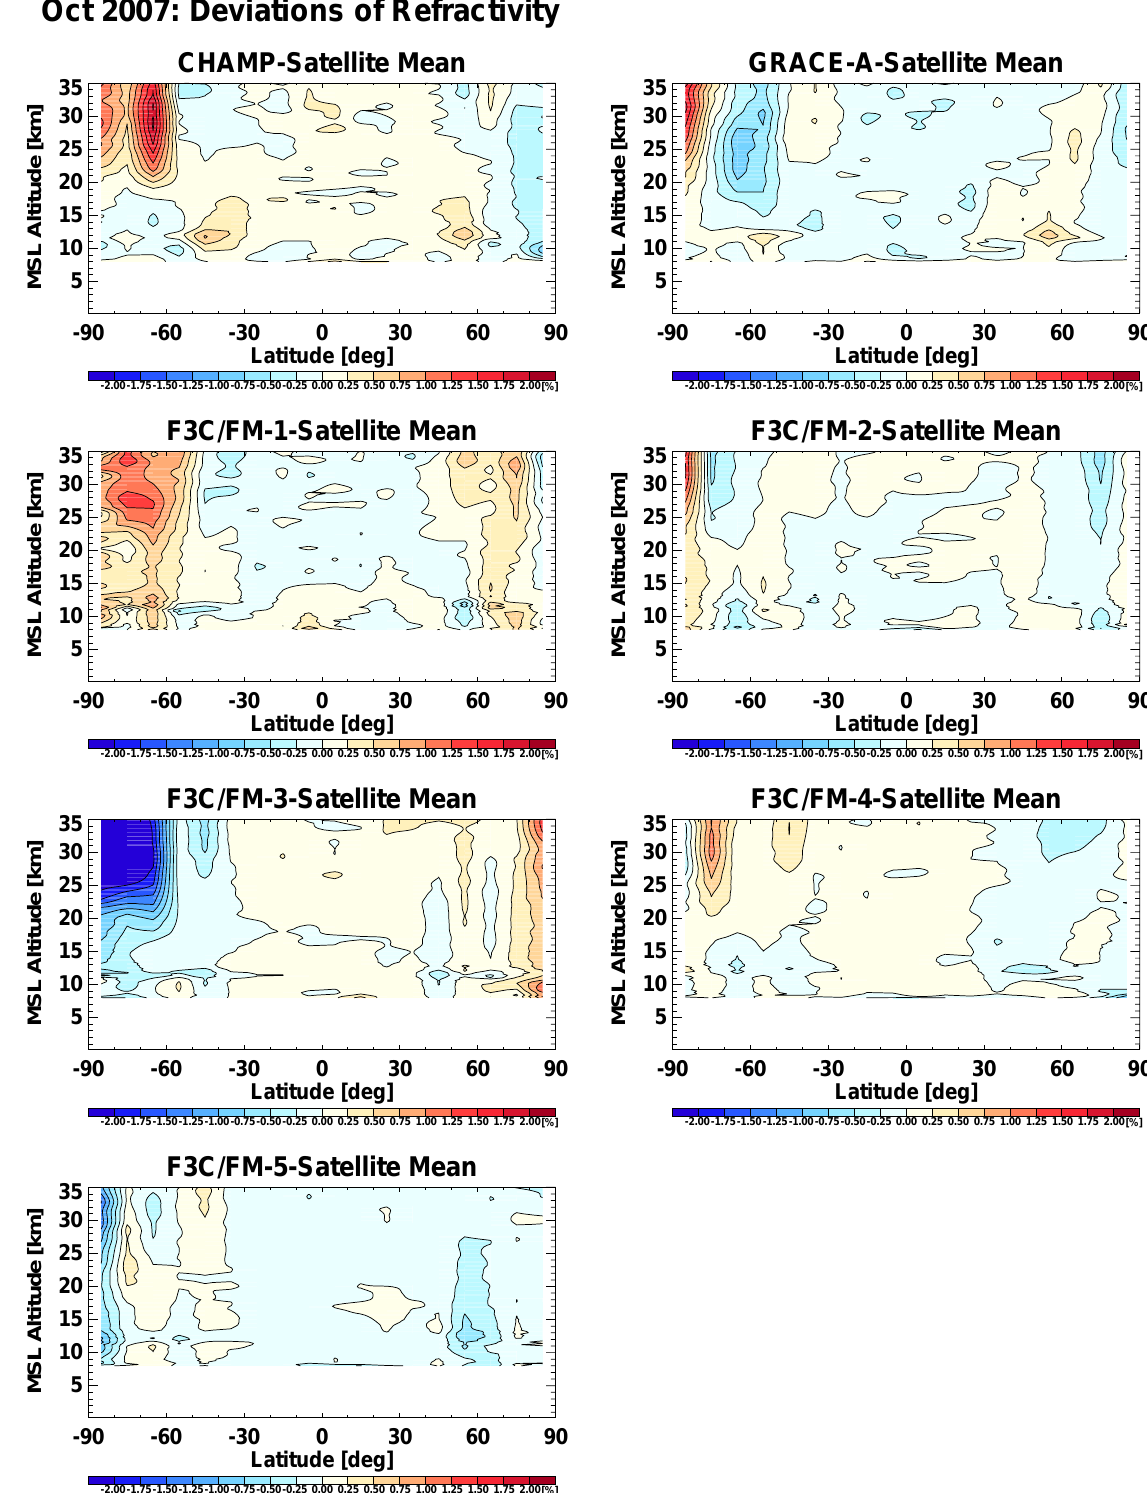
Fig. 2. Monthly mean relative refractivity differences with respect to the multi-satellite mean for October 2007 for seven satellites (name in panel titles, for this month there are no F3C/FM6 data available).